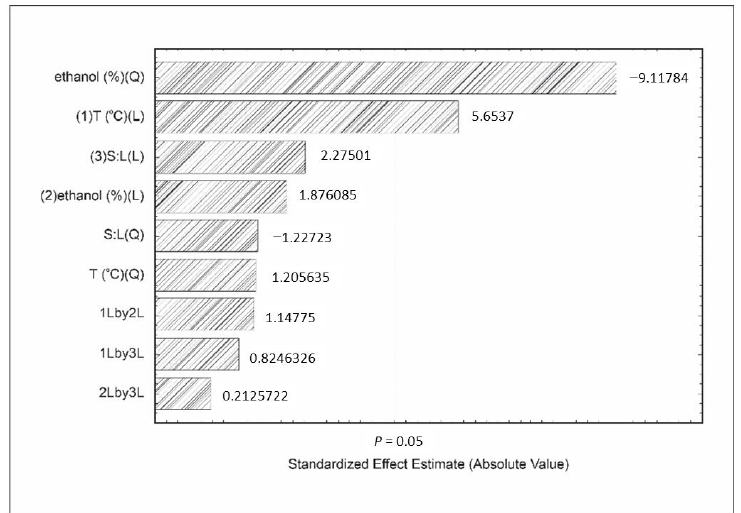
Figure 2. Effect of independent variables on Folin–Ciocalteu reducing capacity assay, where temperature (T) and solid:liquid ratio (S:L).